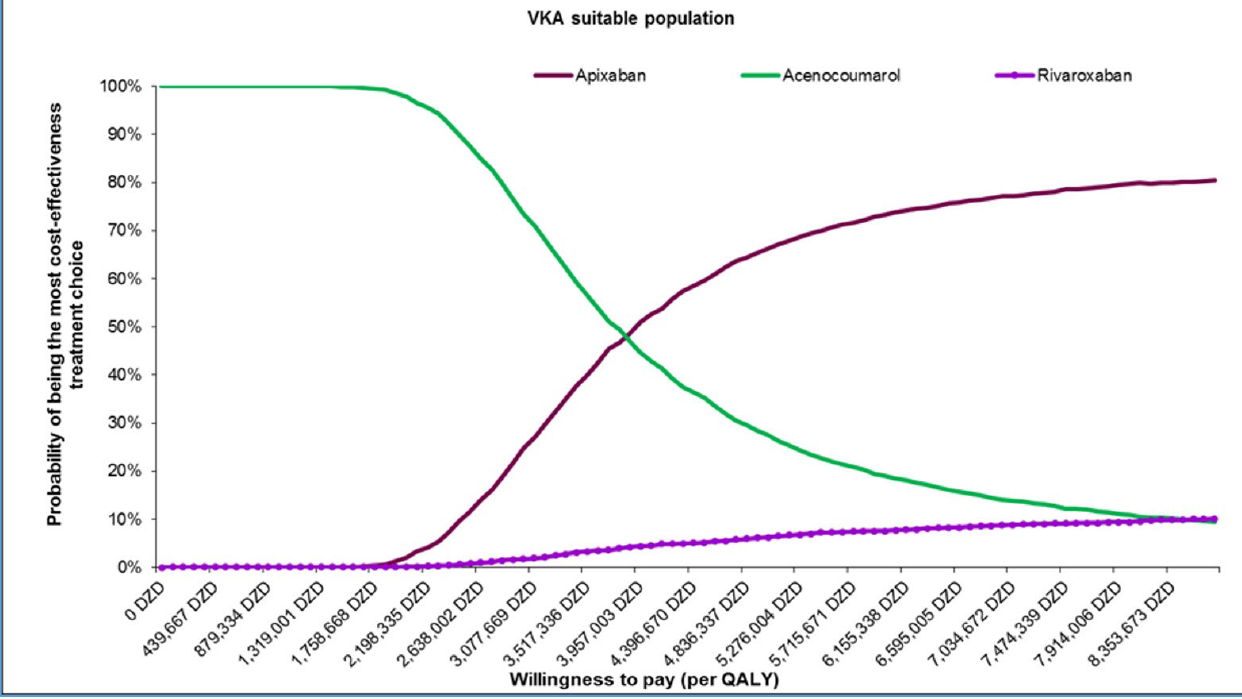
QALY: quality-adjusted life-year; VKA: vitamin K